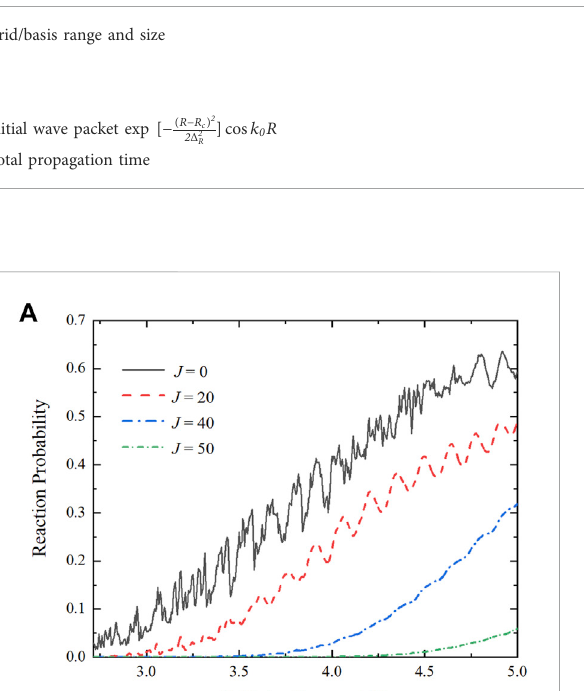
TABLE 3 Main numerical parameters in the TDWP calculations.